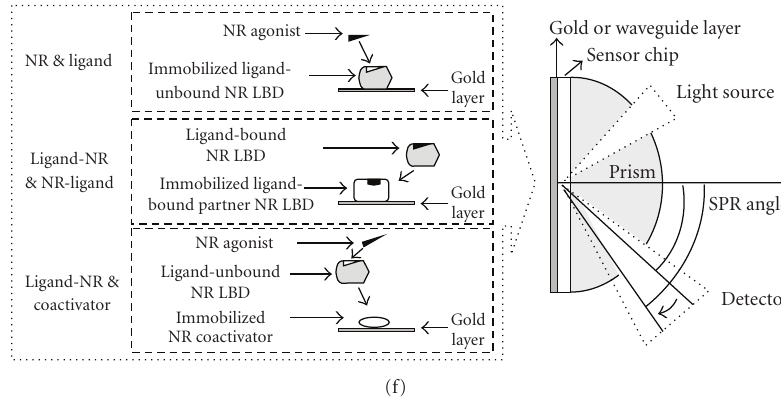
Figure 3: Various cell-free assays to discover PPAR modulator. A. Competition radioreceptor assays are performed by incubating recombinant PPAR protein and radioisotope-labeled ligand in the presence of competitor ligands. Bound ligands are separated from free forms by filtration. The amount of bound radioisotope-labeled ligand is determined by liquid scintillation counting. B. Coactivator- dependent receptor ligand assays (CARLAs) based on the recruitment of a coactivator due to a conformational change of specific ligand-bound PPAR. CARLA is carried out by incubating GST-PPAR and radioisotope-labeled coactivator with a ligand candidate or by incubating radioisotope-labeled PPAR and GST-coactivator with ligand candidates. The amount of ligand-bound PPAR-coactivator complex is determined by pull-down assay. C. In the scintillation proximity assay (SPA), the receptor-ligand complex is bound to the SPA bead through interaction between the biotinylated receptor and the streptavidin moiety located on the surface of the SPA bead. Because no separation step is required, SPA has benefits in its application to HTS. D. In the fluorescence resonance energy transfer (FRET)-based in vitro recruitment assay, GST-PPAR LBD proteins are indirectly linked to EU cryptate, (Eu)K, through (Eu)K-labeled anti-GST antibody, α -GST-(Eu)K. Purified recombinant coactivator is biotinylated, and is indirectly linked to XL665, which is produced only when there is a ligand-induced change in receptor conformation that results in binding to the coactivator. The extent of the FRET is measured as a ratio of 665 nm/620nm X 10,000. E. A simple ELISA based on binding between PPAR and coactivators. The ligand unbound-PPAR weakly binds to the LXXLL motifs of coactivator, whereas ligand loaded-PPAR strongly binds to the LXXLL motifs of coactivator due to the conformational change of PPAR by specific agonists. This binding is detected by a specific anti-PPAR antibody, followed by horseradish peroxidase-conjugated secondary antibody. F. Schematic representation of SPR technology. One of the interacting partners is immobilized on a gold or waveguide layer of the sensor chip using the standard amine-coupling protocol. The other flows over the surface of the sensor chip, allowing interaction with the immobilized interacting partners. The interaction of immobilized partners with interacting molecules gives rise to an increase in mass. The refractive index and the angle of reflected light is thereby changed. As soon as the injection is stopped, the complex is washed with a washing bu ff er. The interacting molecules are dissociated from the immobilized interacting partner, resulting in a decrease in the signal due to a shift in the angle of the reflected light to its original